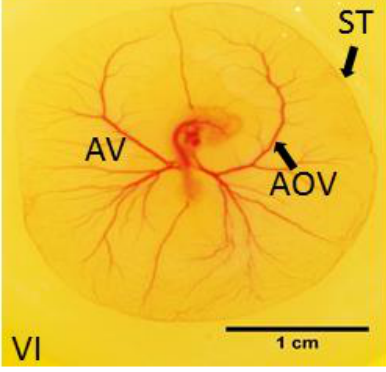
Figure 1. Parameters for measurement of extra-embryonic vasculature formation: sinus terminalis (ST, in cm), size of area vasculosa (AV, in cm 2 ), absolute area vasculosa (AOV, in cm 2 ), and vascular index (VI, in %). Scale bar 1 cm.